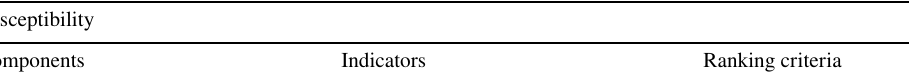
Table 1 Sensitivity/susceptibility indicators and ranking